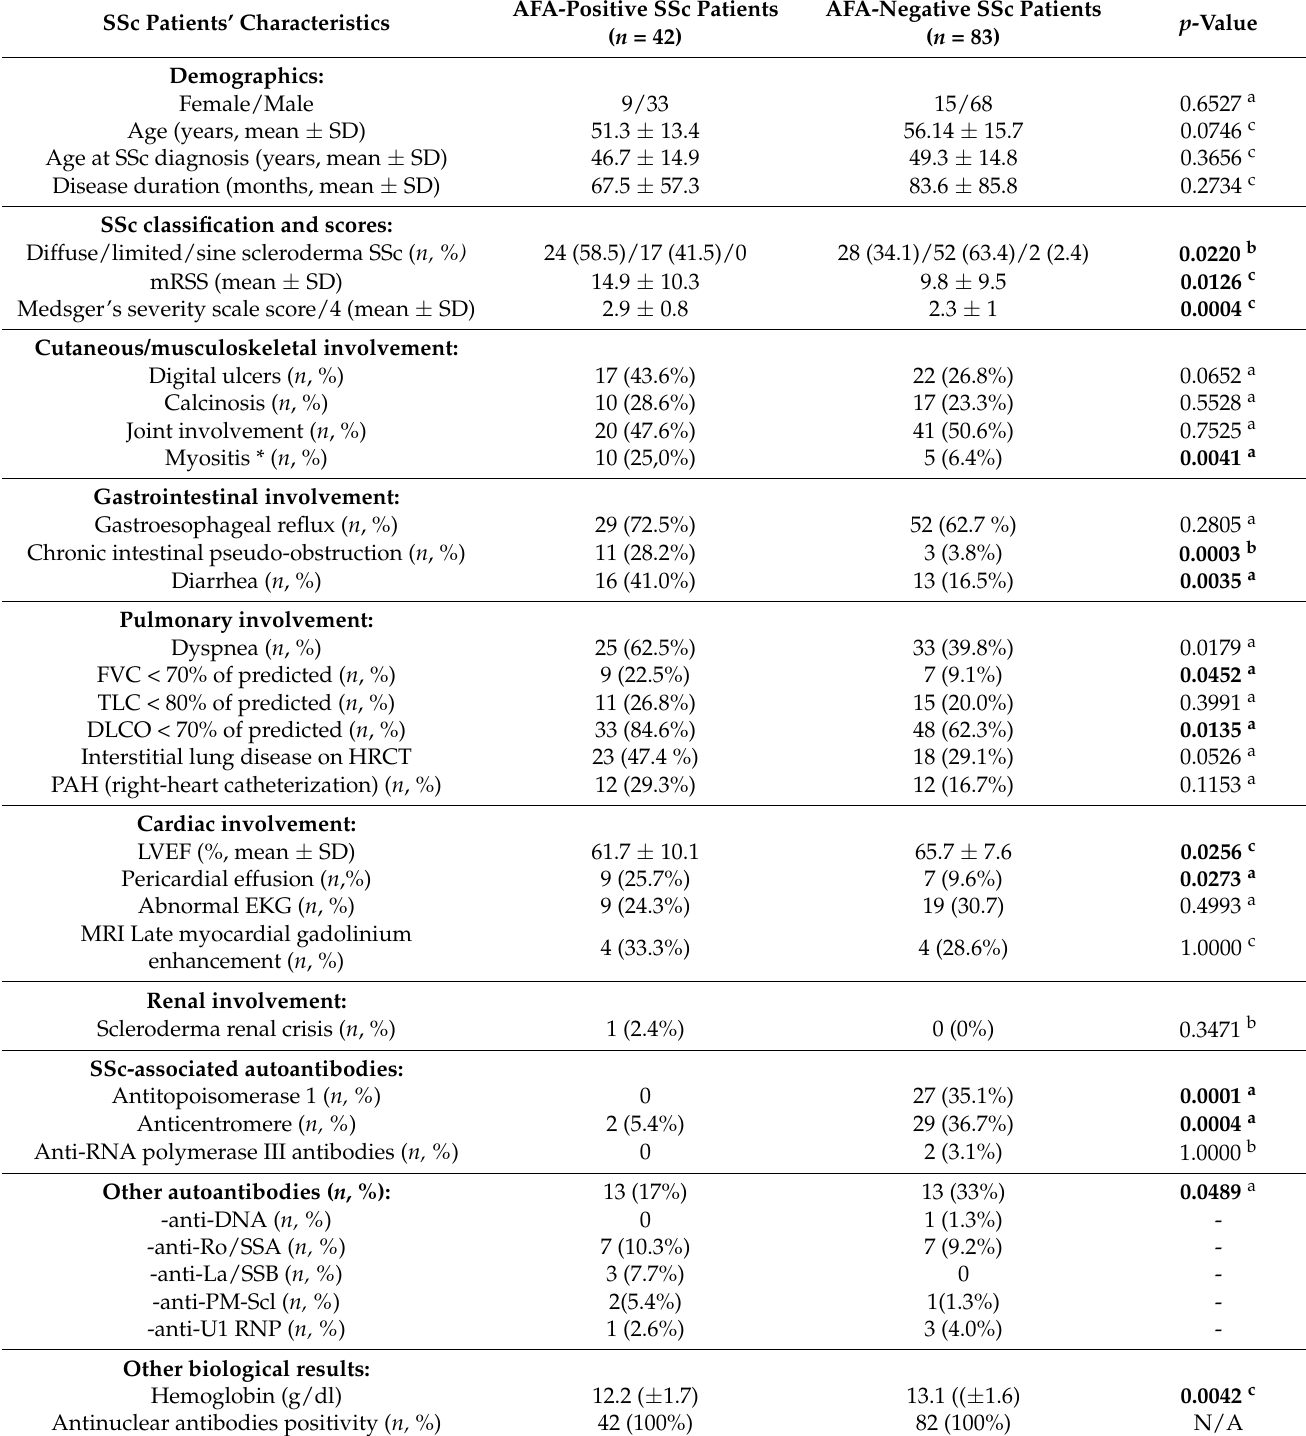
Table 1. Comparison of clinical and immunological characteristics between antifibrillarin autoantibody (AFA)-positive and AFA-negative SSc